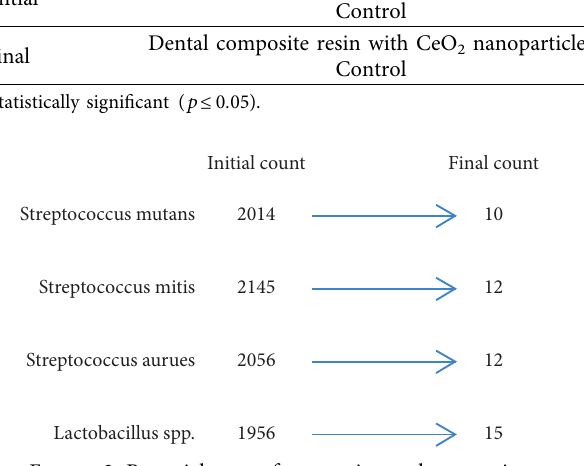
Table 5: Comparison of microbial count (CFU/ml) between the experimental group and control group for Lactobacillus sp. Microbial count Dental composite resin with CeO 2 nanoparticles 5 1951.80+6.26